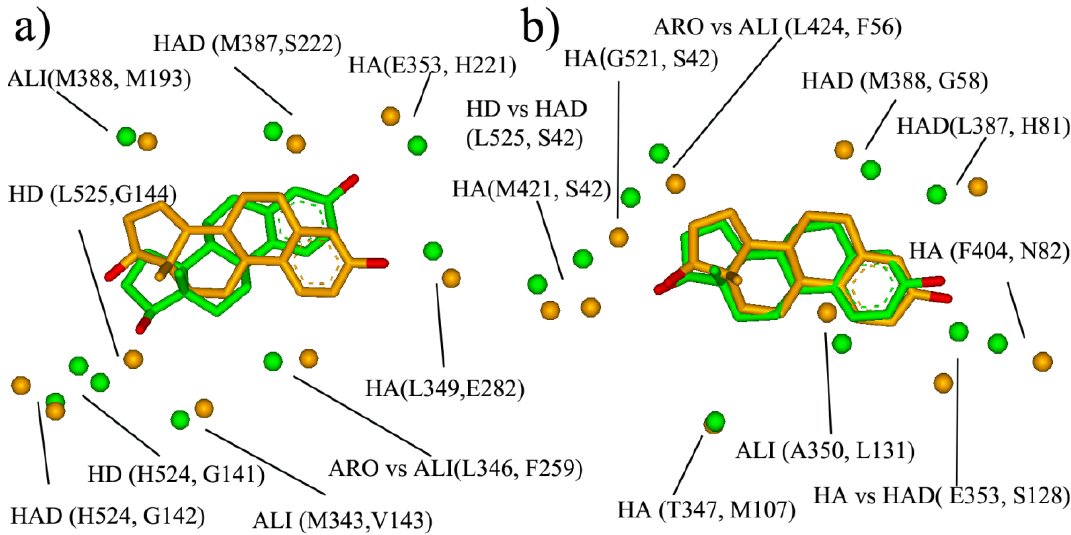
Figure 6. The similar sites and subsites: ( a ) the similar site of ER (in green, PDB entry: 1GWR) and 17- β -HSD (in orange, PDB entry: 1IOL); ( b ) the similar site of ER (in green, PDB entry: 1GWR) and sex hormone binding globulin (in orange, PDB entry: 1LHU).